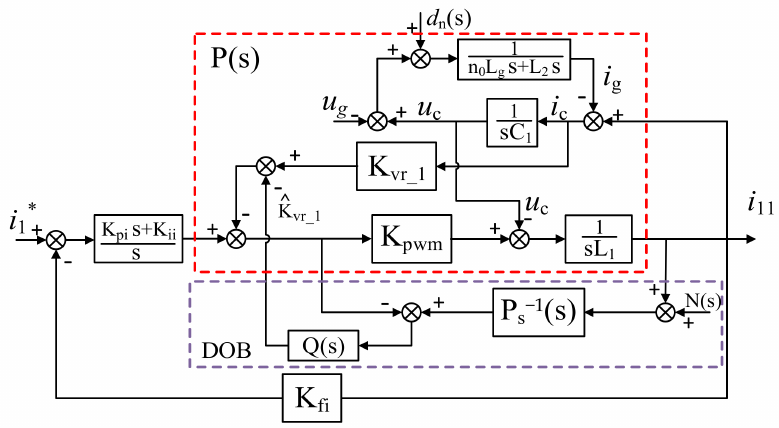
Figure 10. Control block diagram of the active damping resonance suppression strategy based on a disturbance